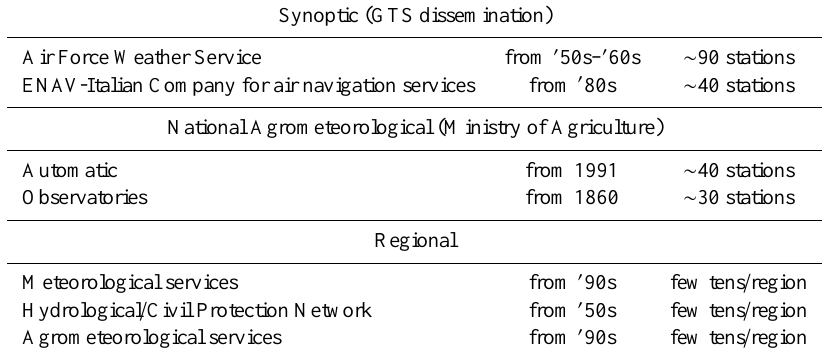
Table 1. Main meteorological Italian networks and data